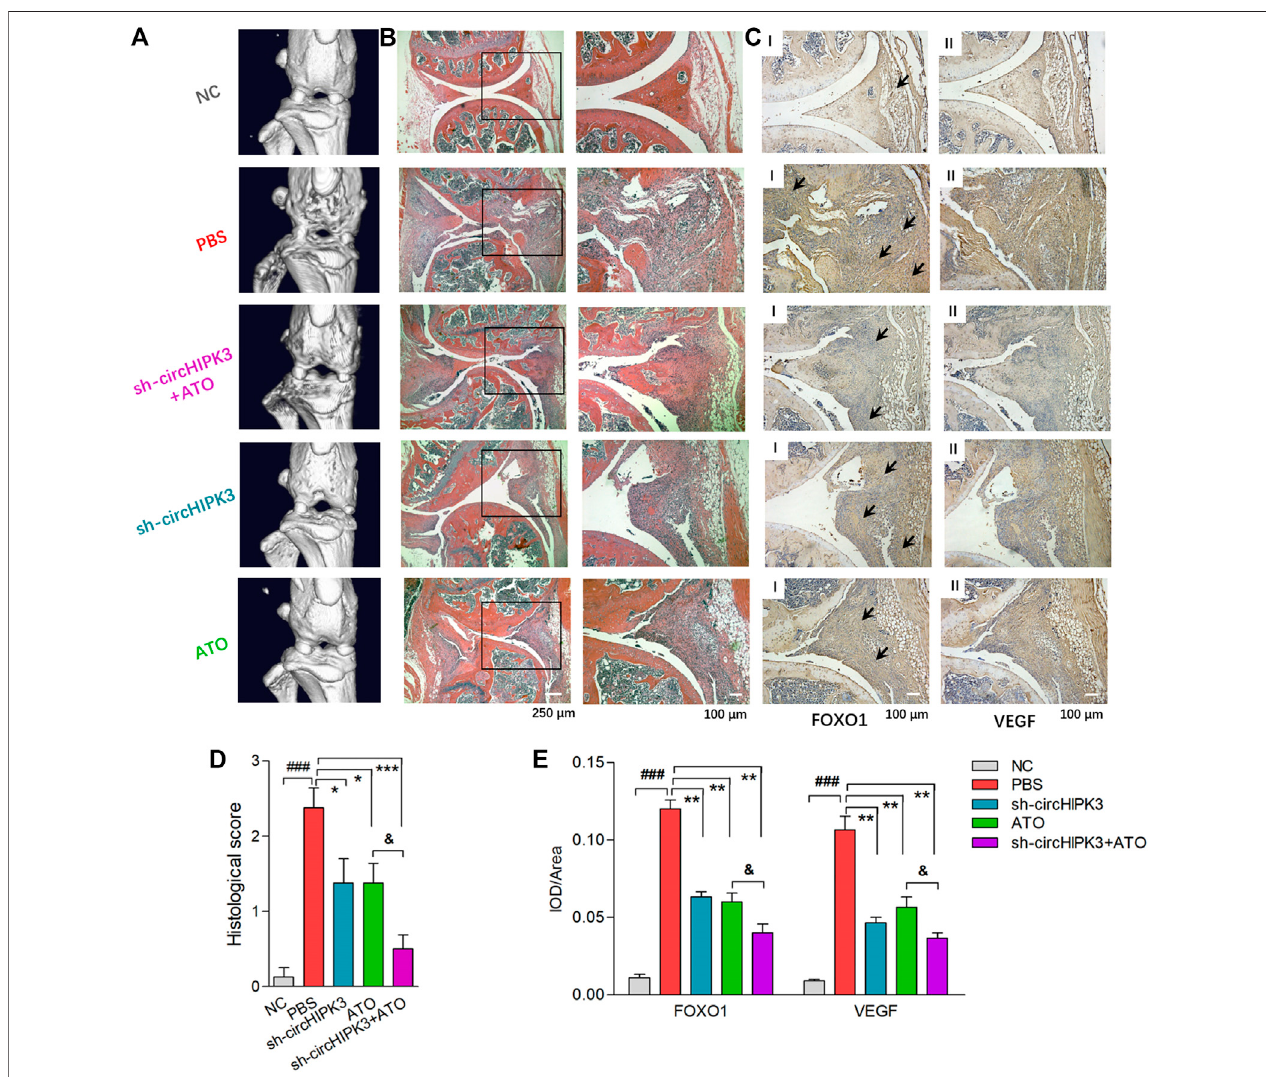
FIGURE 6 | Histological evaluation of single or combined treatment of AAV-sh-circ-HIPK3 and ATO. (A) Micro-CT images of knee joints demonstrated the destruction of bone and cartilage in CIA mice, and ATO injection alleviated the joint destruction. AAV-sh-circHIPK3 combined with ATO could signi fi cantly reduce the damages of bone compared to ATO therapy alone. (B) The severity of arthritis in CIA mice was assessed by H&E staining of knee joint sections. ATO treatment at 2.0 mg/kg/day and AAV-sh-circHIPK3 injection, respectively, signi fi cantly reduced synovial hyperplasia, cartilage/bone erosion and joint in fl ammation compared withCIA controlmice.Additionally, thecombinationtherapyofATOand AAV-sh-circHIPK3yieldedmore reduction ofpannusformationand in fl ammatory in fi ltration. (C) ImmunohistochemicalanalysiswasperformedtoevaluatetheeffectofAAV-sh-circHIPK3andATOonFOXO1( Ⅰ )andVEGF( Ⅱ )expressioninsynovialtissuesofCIAmice. CIA mice under PBS treatment had signi fi cantly increased staining intensity of FOXO1 and VEGF compared with normal mice. And the injection of AAV-sh-circHIPK3 or ATO signi fi cantly decreased staining forFOXO1 and VEGFcomparedwithCIA control mice. Interestingly, FOXO1and VEGF stainingin thecombinedtreatmentofAAV- sh-circ-HIPK3 andATOgroupweresigni fi cantlyweakerthanthoseintheCIAmice underATOtherapyalone.Histologicalscores (D) and averageIODvaluesforFOXO1 andVEGFimmunostaininginthekneejointsynovium (E) were,respectively,evaluatedandshown(n (cid:1) 5;* p < 0.05,** p < 0.01,*** p < 0.001versusPBStreatmentgroup; ### p < 0.001 versus NC; and p < 0.05 versus ATO group). Data are expressed as the mean ± SEM. NC (cid:1) normal control